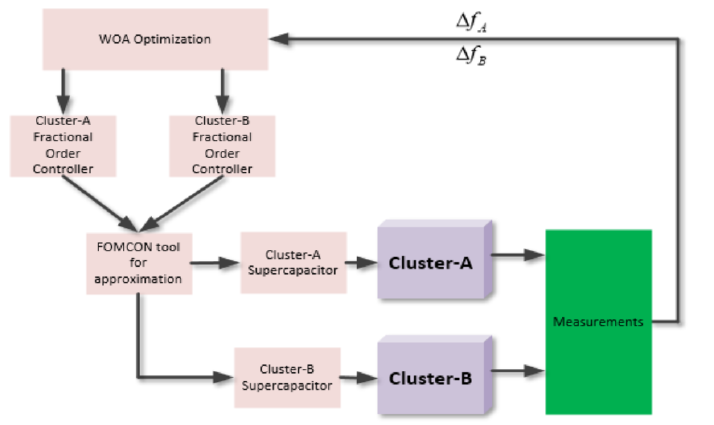
Figure 5. Fractional-order supercapacitor implementation